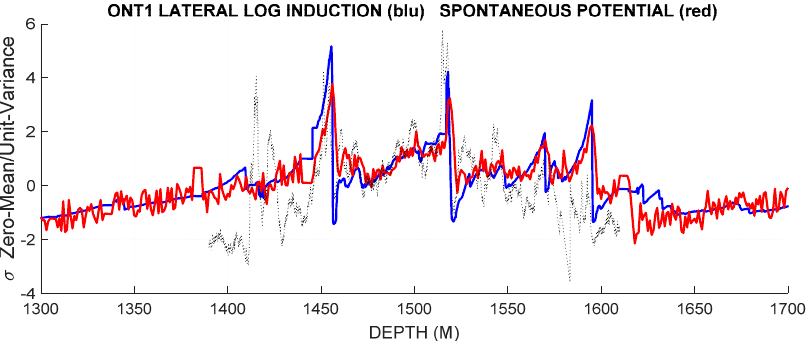
Figure 19. OTN1 galvanic property well-log data from granitic interval 1400 m–1600 m. For purposes of comparison, the three data sequences are scaled to zero-mean/unit-variance format. As seen in Figure 2, the reference temperature deflections (black dots) range from − 0.05 ◦ C to +0.15 ◦ C relative to the local temperature trend. Lateral log induction variations are shown in blue; spontaneous potential variations are shown in red. The temperature data are shifted 10 m due to depth discrepancy between separate well-log operations.